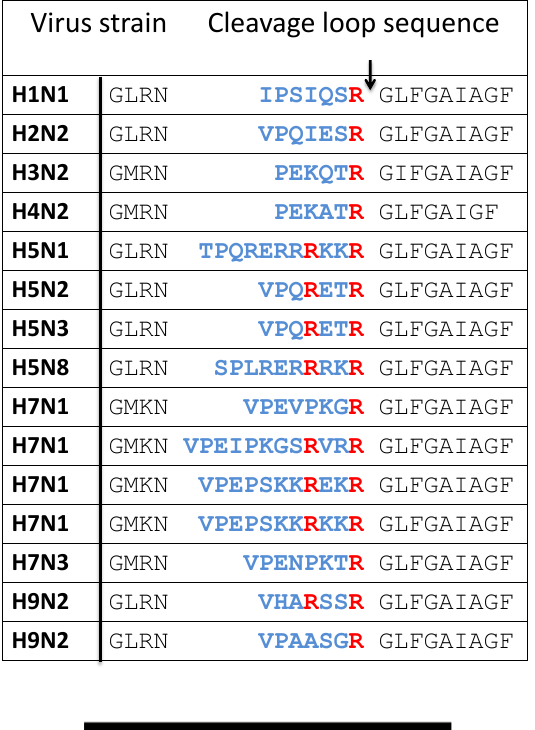
Table 5 . Cleavage loop in the HA protein of influenza viruses. The variable region is blue with the arrow denoting the cleavage site. The P4Arg and P1Arg residues are colored red.